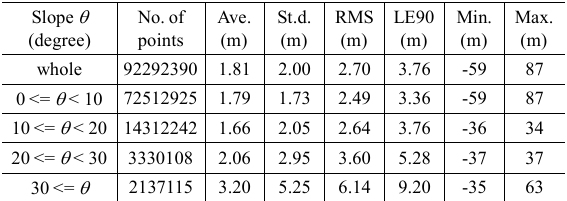
Table 6. Statistics of height difference between the DSM tile data and the LiDAR/DEM (DSM tile data minus LiDAR) for different ranges of slope angles as well as for whole data.